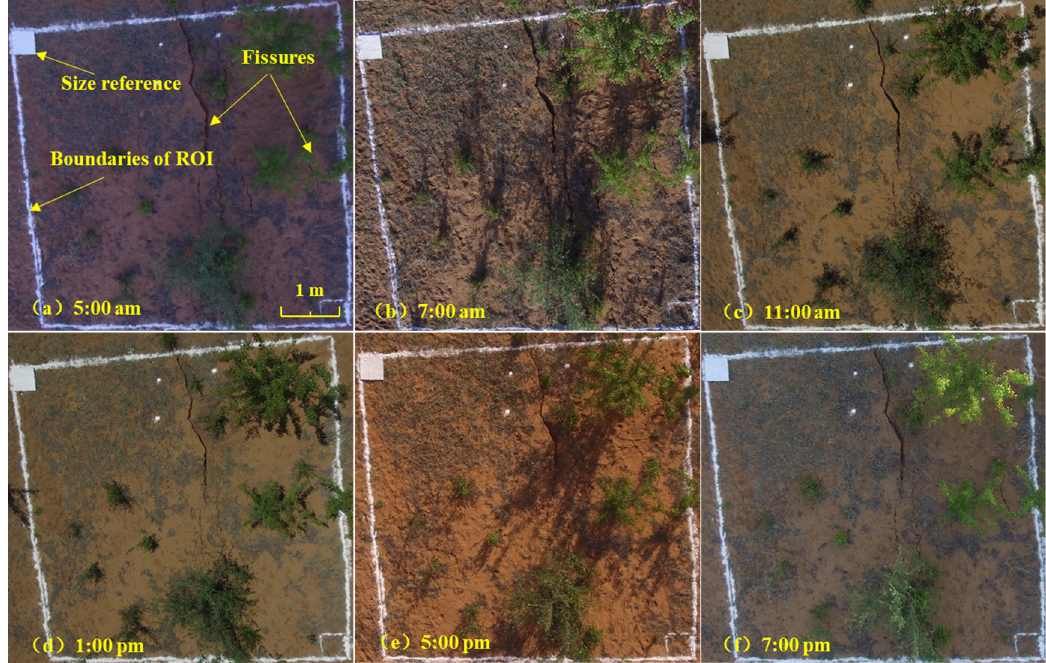
Figure 4. Visible images at different time points. ( a ) 5:00 a.m; ( b ) 7:00 a.m; ( c ) 11:00 a.m; ( d ) 1:00 p.m; ( e ) 5:00 p.m; ( f ) 7:00 p.m.